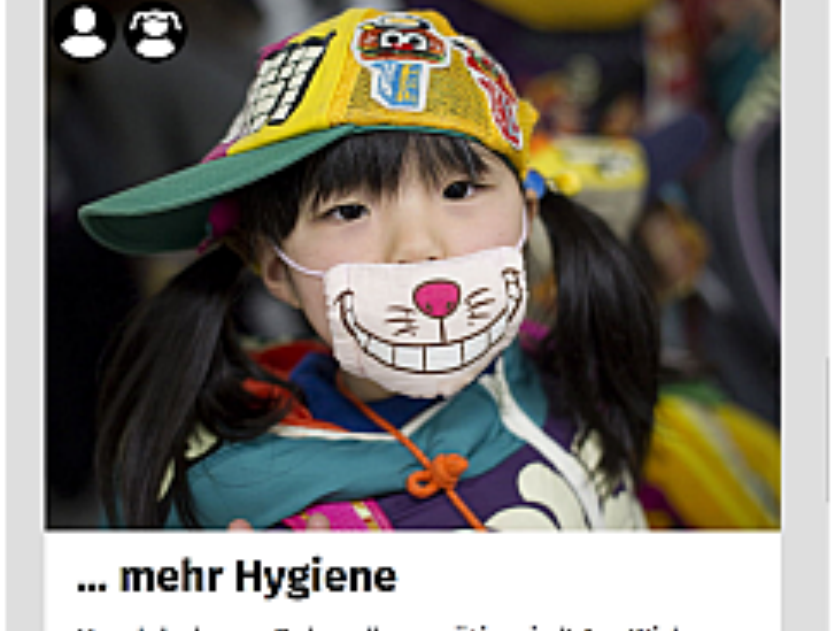
Figure 2. Screenshot of the study-specific website in German (“Fewer antibiotics…more